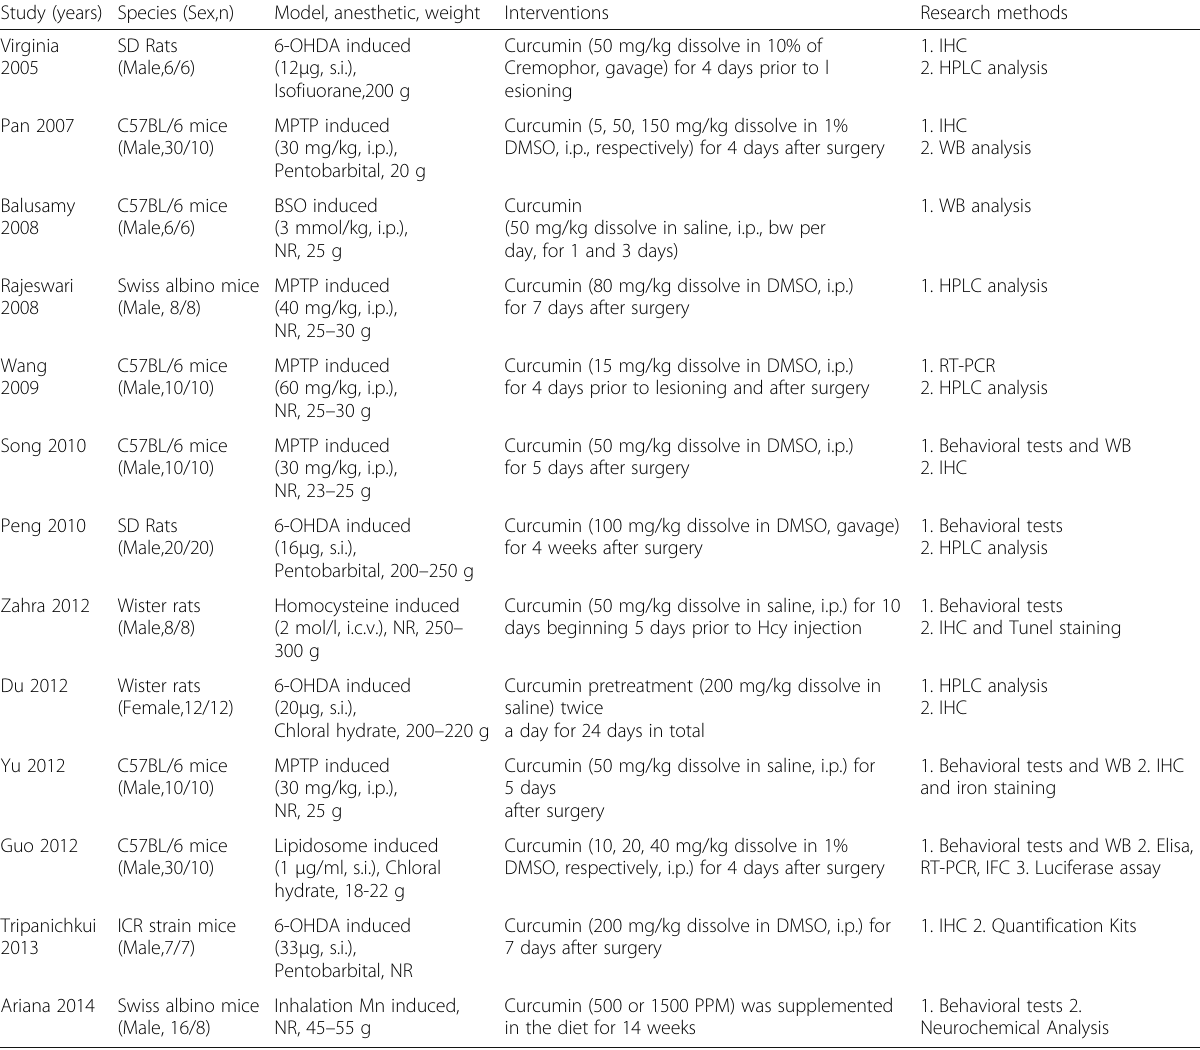
Table 1 Basic information of included studies